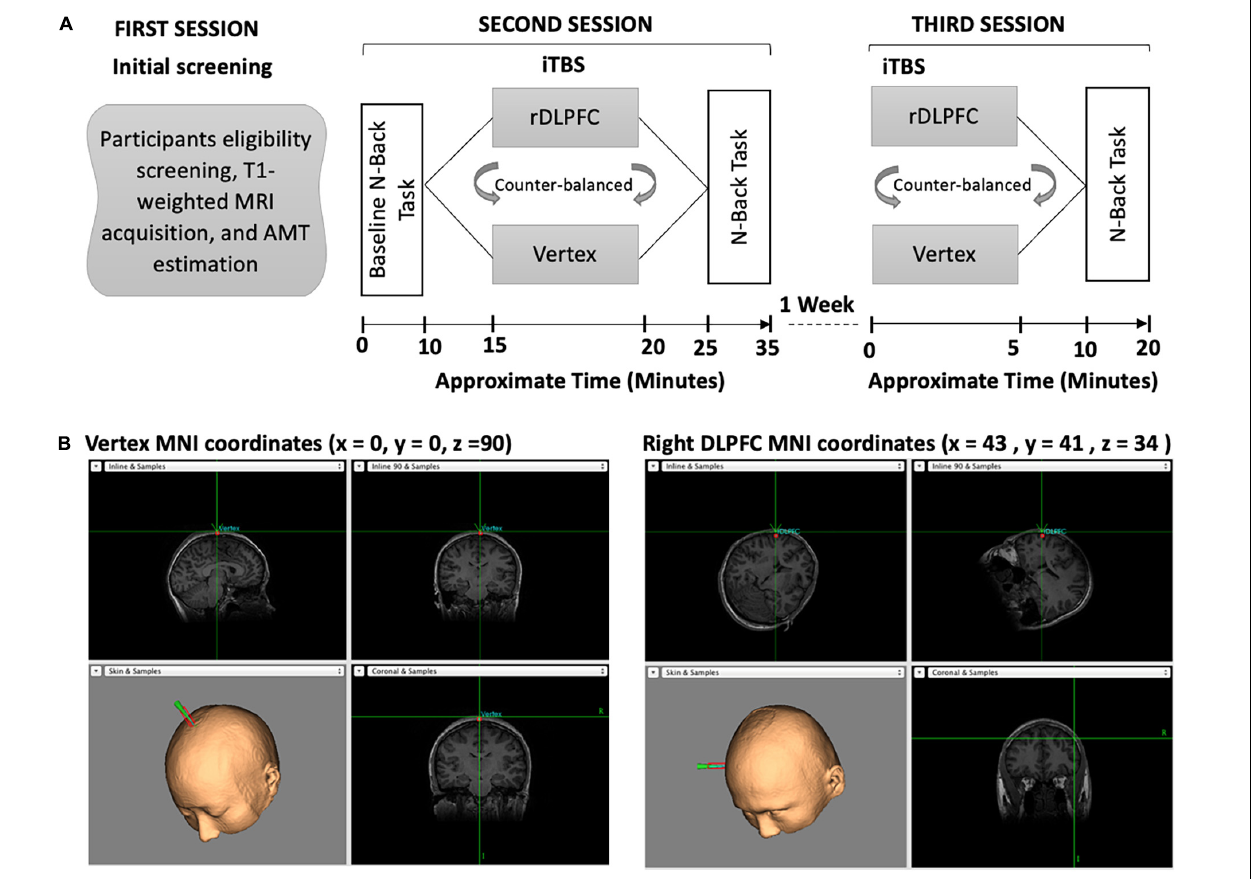
FIGURE 1 | (A) Overview of the experimental paradigm. Our experiment consisted of three separate sessions. During the first session, the participants were screened on eligibility, had their T1-weighted images acquired, and AMT estimated. In the second session, participants performed the baseline n-back task followed by iTBS and then the post-stimulation n-back task. In the third session, the participants received iTBS and performed the post-stimulation n-back task. (B) The iTBS target brain areas, the vertex and the Rdlpfc,